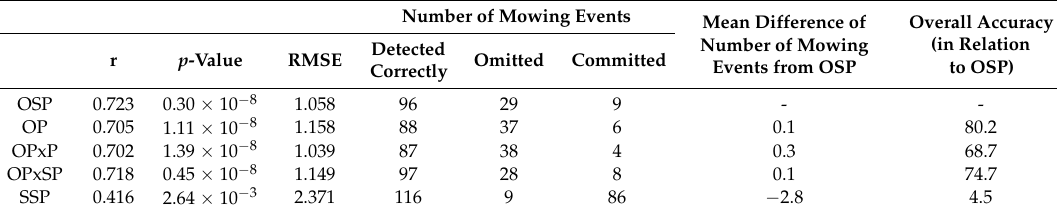
Table 3. Accuracy assessment of analyzed strategies: various spatial mapping units and cloud masking levels, number of correctly detected, and omitted and committed mowing events. r, correlation coefficient; p , significance, Optimized-parcel (OP).